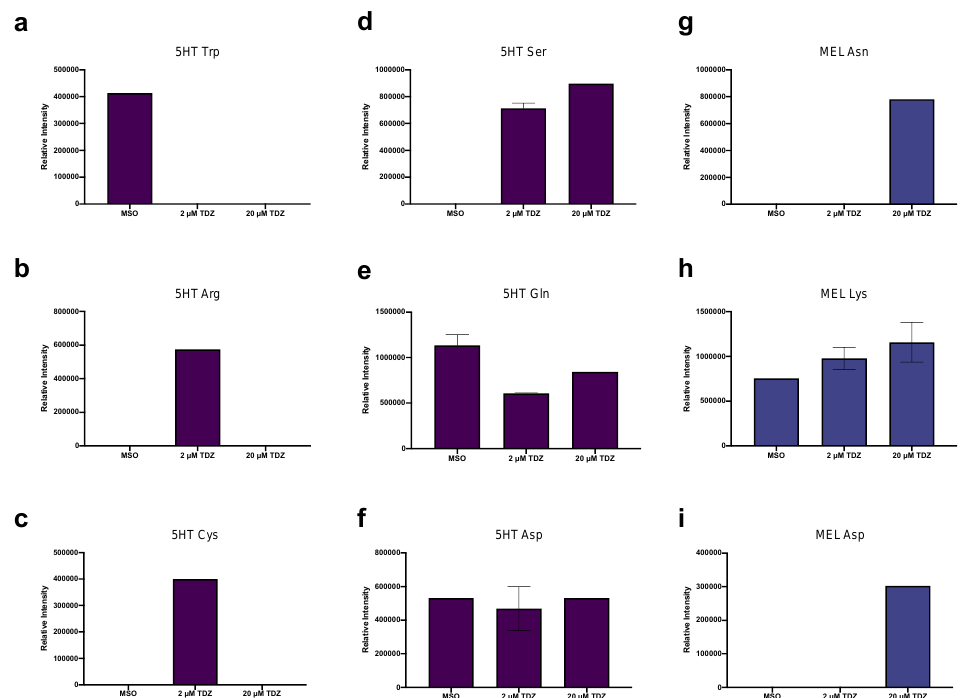
Figure 7. Effects of thidiazuron (TDZ) exposure on proposed indoleamine (serotonin, 5HT and melatonin, MEL) amino acid conjugates in African violet petioles. Purple denotes 5HT conjugates ( a – f ), blue MEL conjugates ( g – i ). Bars represent mean, error bars span standard error margin. Where no error bars are displayed, the feature was present in only one replicate.